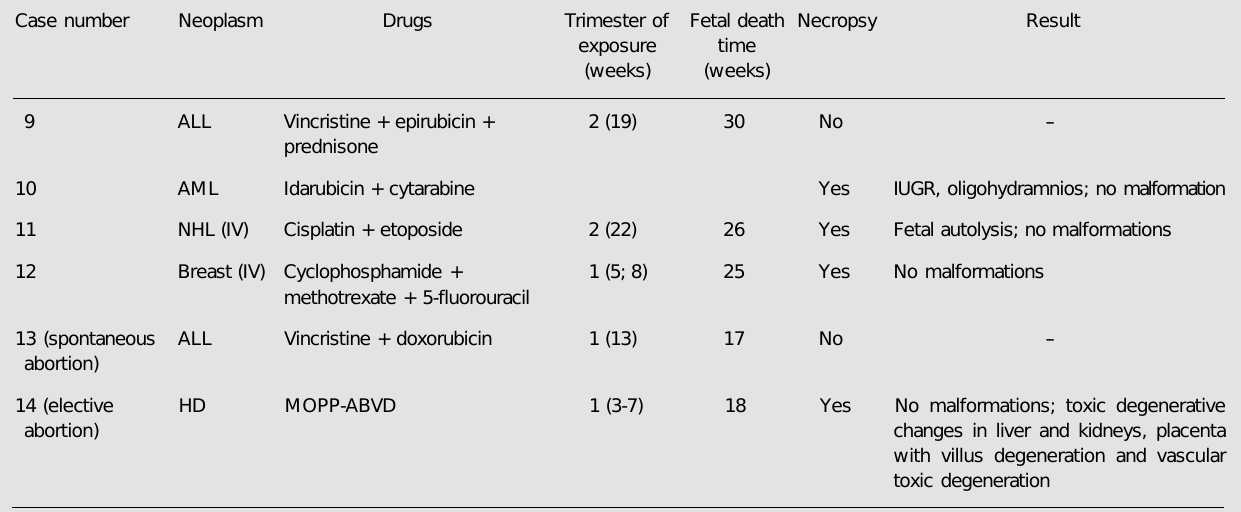
Table 4. Exposed group: outcome (pregnancy losses) and chemotherapy employed. Case